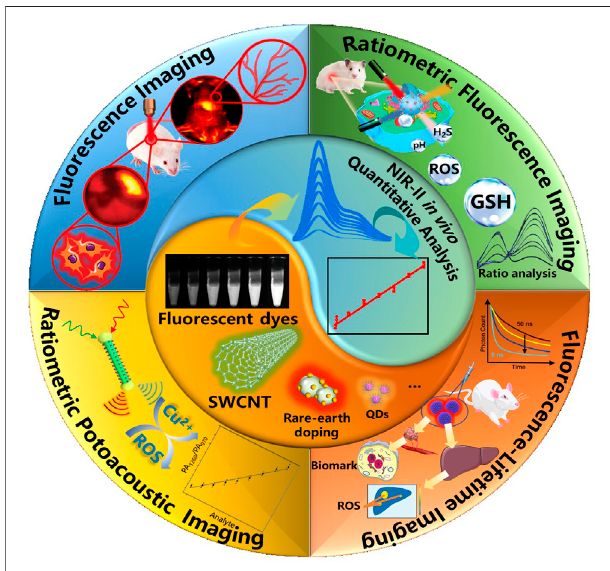
FIGURE 1 | Schematic illustration of NIR-II bioimaging for in vivo quantitative